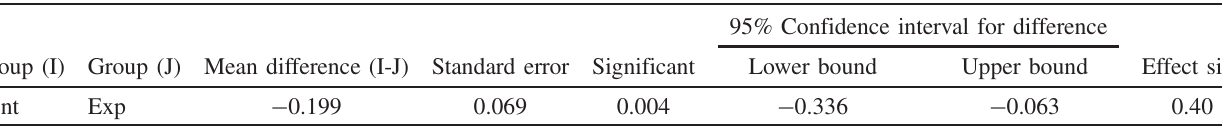
TABLE VI. Pairwise comparison of the variance of pre-post gains between experimental group and control group for justification for knowing factor.